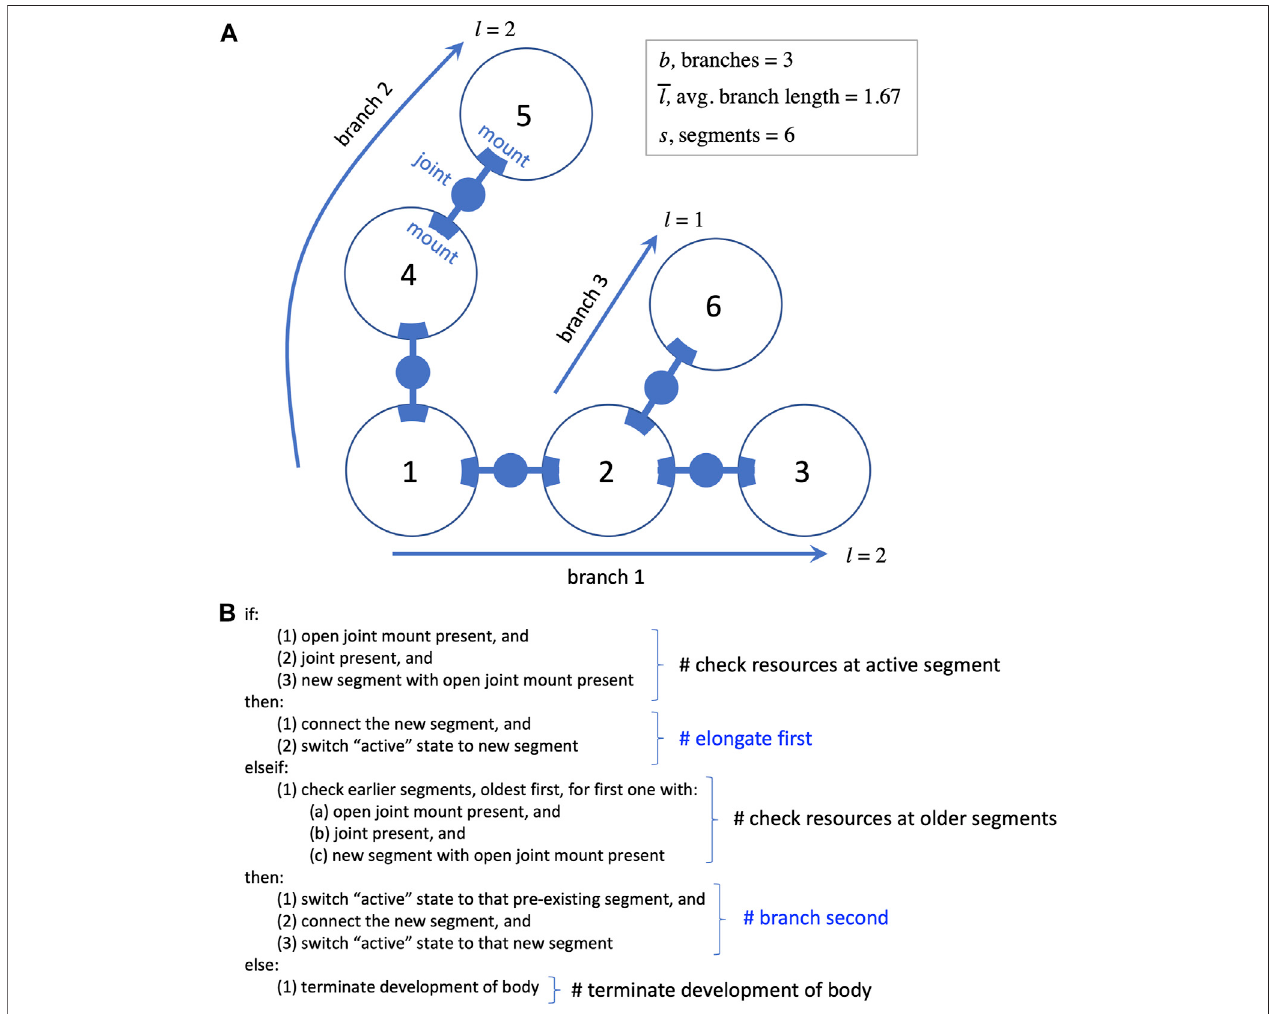
FIGURE 2 | Development of the biorobot ’ s segmented and branched body. (A) Every biorobot is built from 3D spherical segments (represented as circles here) connected byjoints that attach tomounts.Sensorimotor morphologies — sensors, wires,and neurons — arenot shown. Duringdevelopment, each segmentisadded to thenextinorderinwhichit fi nisheddevelopment(numbersincircles).Thelengthofabranchisthesegmentsaddedtothebasesegmenttoformthebranch. (B) Rulesof segment-branch developmentinpseudocode.Abranchelongates(seebranch1)untilthenewlyaddedsegmentrunsoutofresources,suchasopenjointmounts (segment 3). Then the algorithm checks for resources starting back at segment 1, until a mount and a joint are found to form a new branch. Elongation is favored by occurring before branching in the algorithm. Elongation and branching continue until segments, open mounts, or joints are depleted, at which time development proceeds to add touch sensors, neurons, and wires to each segment in the order of their segmental development (not pictured).